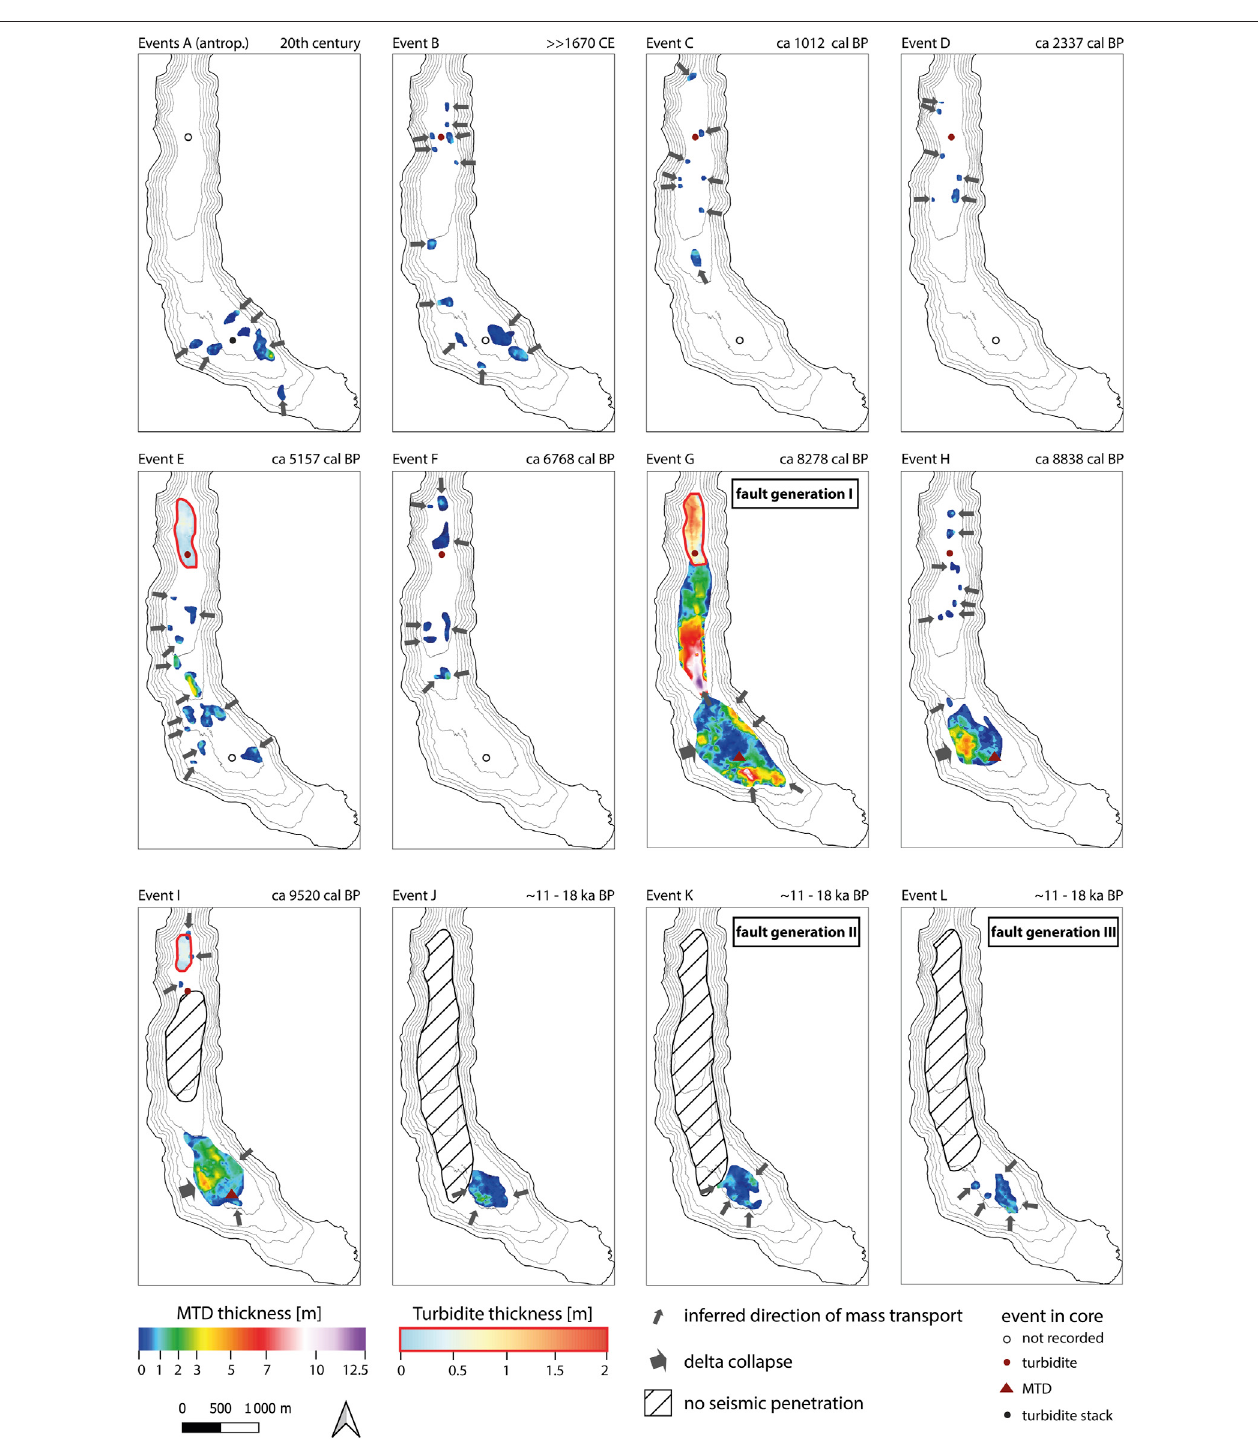
FIGURE 8 | Distribution and thickness maps of MTDs and megaturbidites of seismic-stratigraphic event horizons A-L. Symbols and color code of the coring sites provides information on the sedimentary imprint of the event in the cores. See main text for interpretation and dating of the individual events.